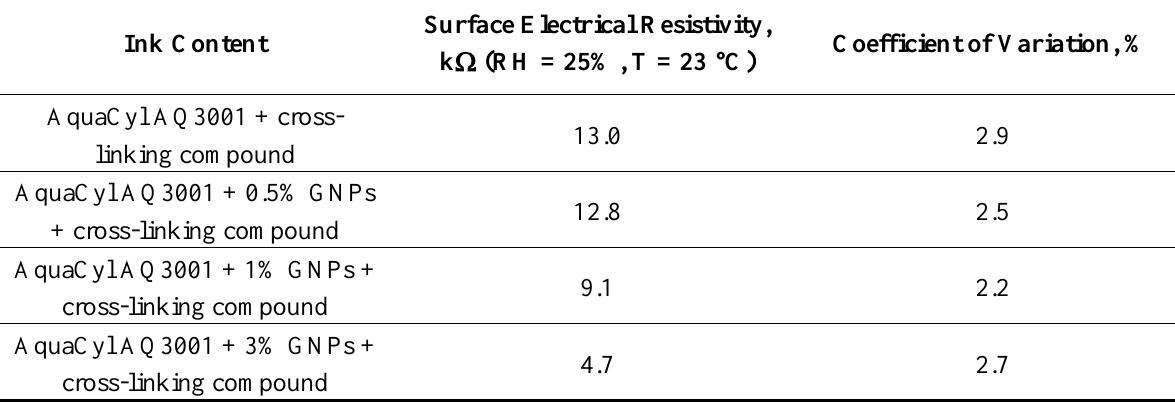
Table 1. The results for the surface electrical resistivity measurements of the printed